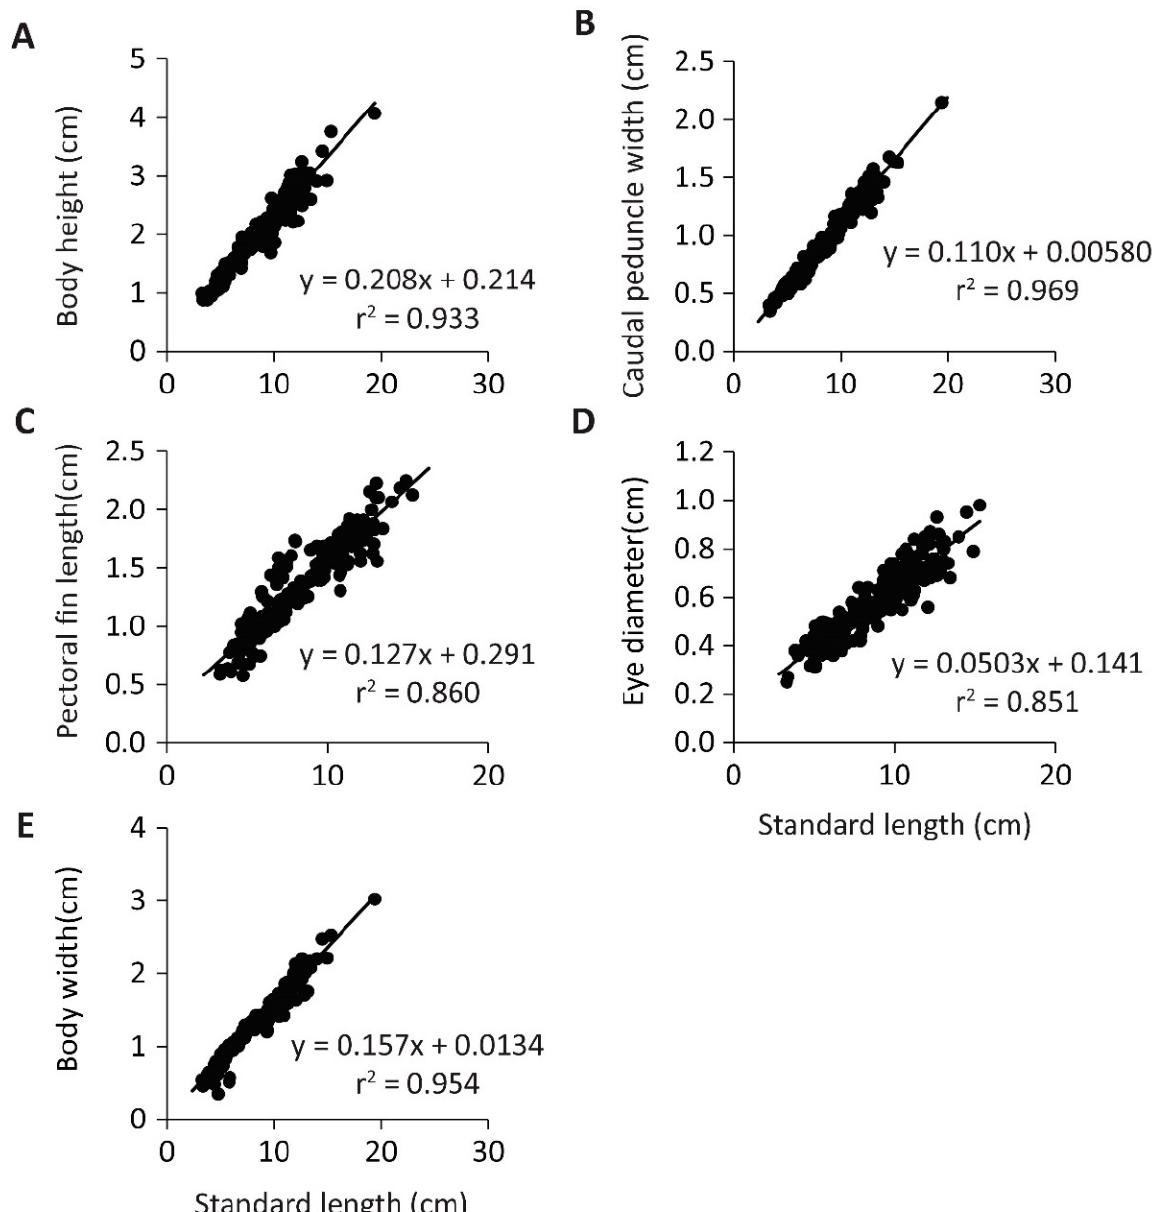
Figure 3. Linear regressions between the morphological traits and standard length (SL) in the greenback mullet ( Liza subviridis ) sampled in Dongzhaigang Bay, Hainan Province, China from July 2020 to April 2021. ( A ): body height vs. SL; ( B ): caudal peduncle width vs. SL; ( C ): pectoral fin length vs. SL; ( D ): eye diameter vs. SL; ( E ): body width vs. SL.